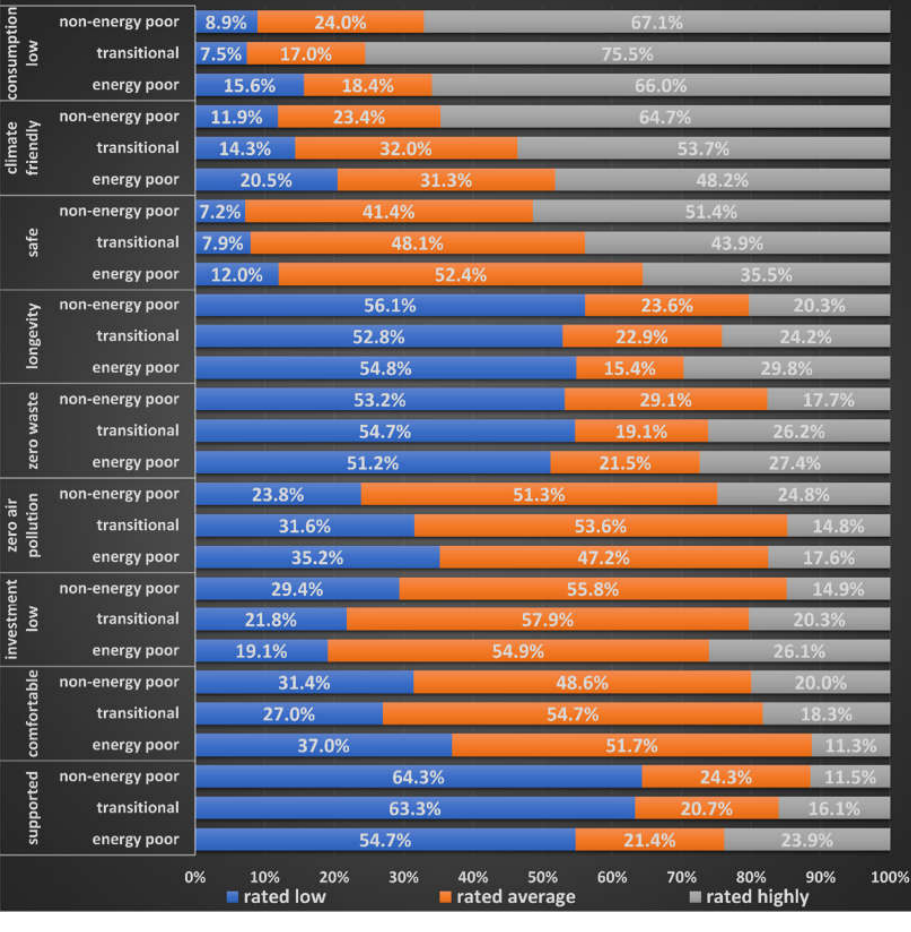
Figure 5. Rating of aspects of heating energy generation by energy vulnerability groups (only significant differences). Compiled by the authors. significant differences). Compiled by the